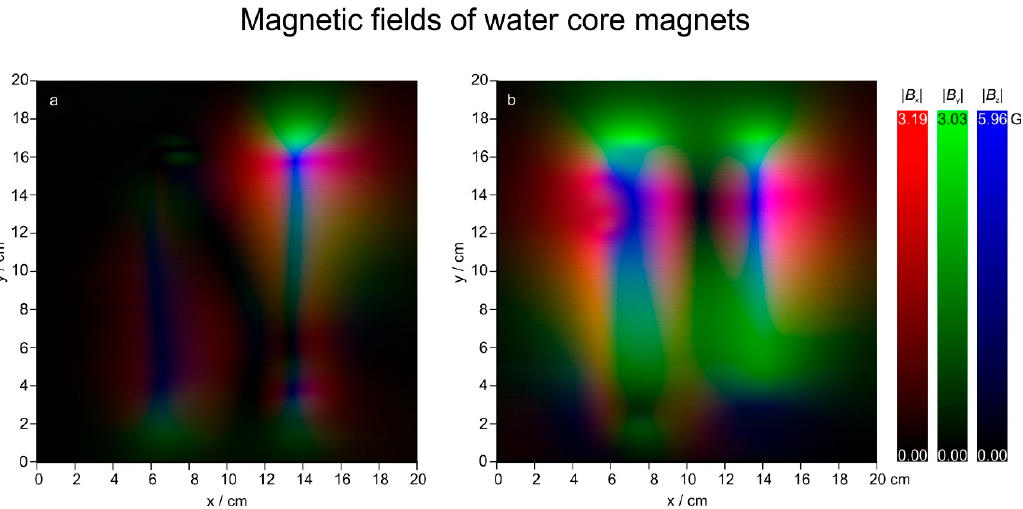
Figure 9 should be replaced by the following figure: Water 2020 , 12 , x FOR PEER REVIEW